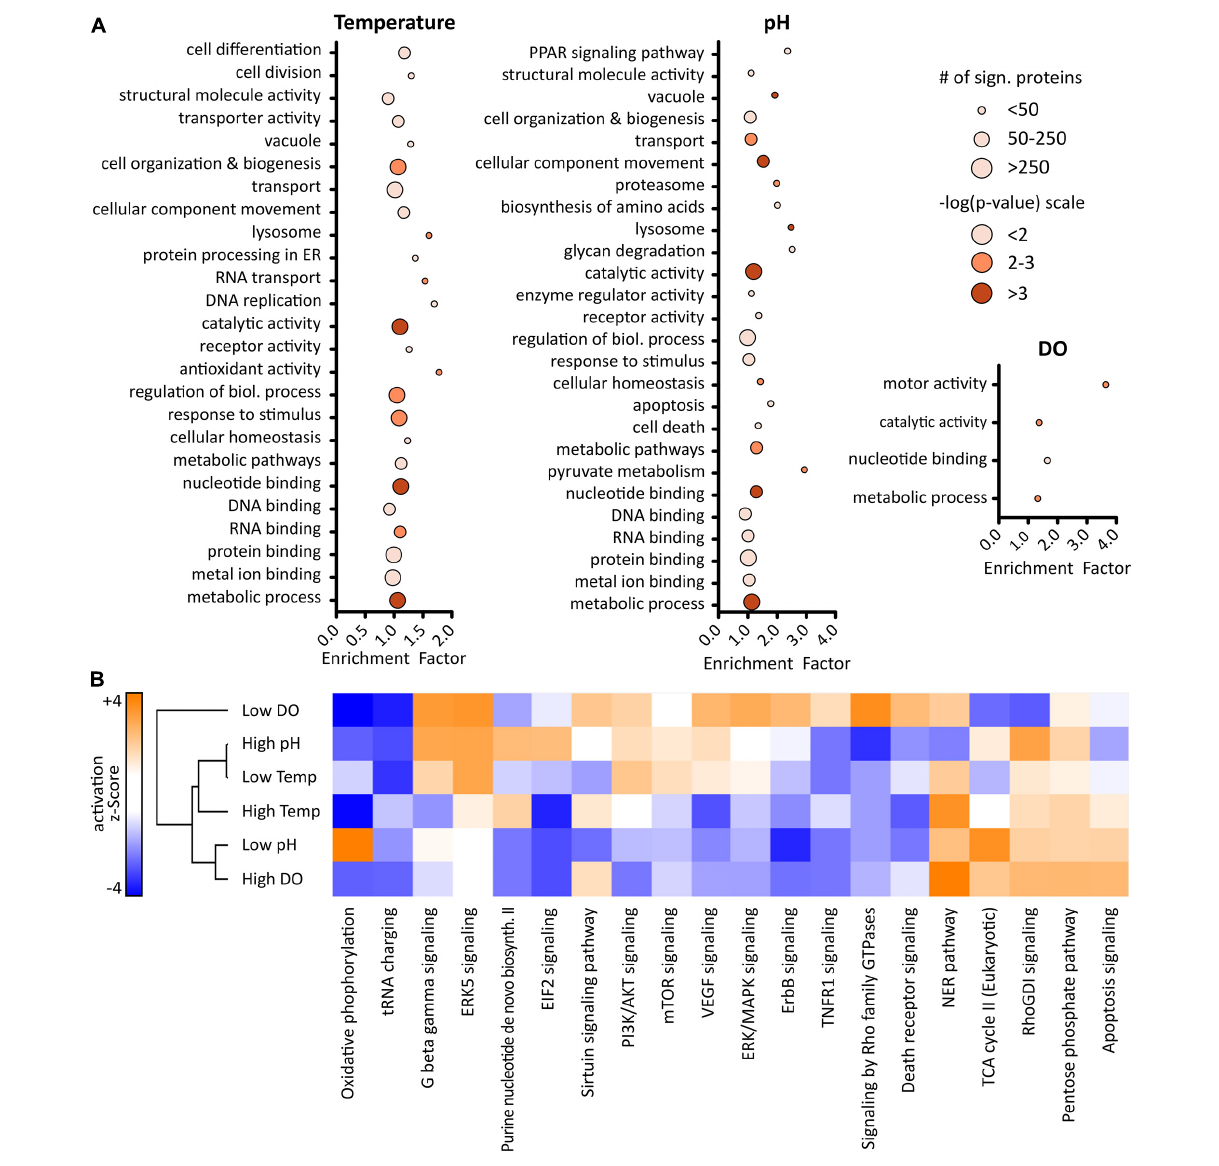
FIGURE 5 | Results of gene ontology (GO) enrichment analysis (A) using a Fisher’s exact test with a p -value ≥ 0.05 performed in Perseus (version 1.6.6). Size of the dots represents number of proteins related to corresponding GO term, color indicates level of significance based on p -value. Ingenuity pathway analysis (B) revealed predicted pathway activation (orange) or inhibition (blue). Activation z -scores greater ± 2 are